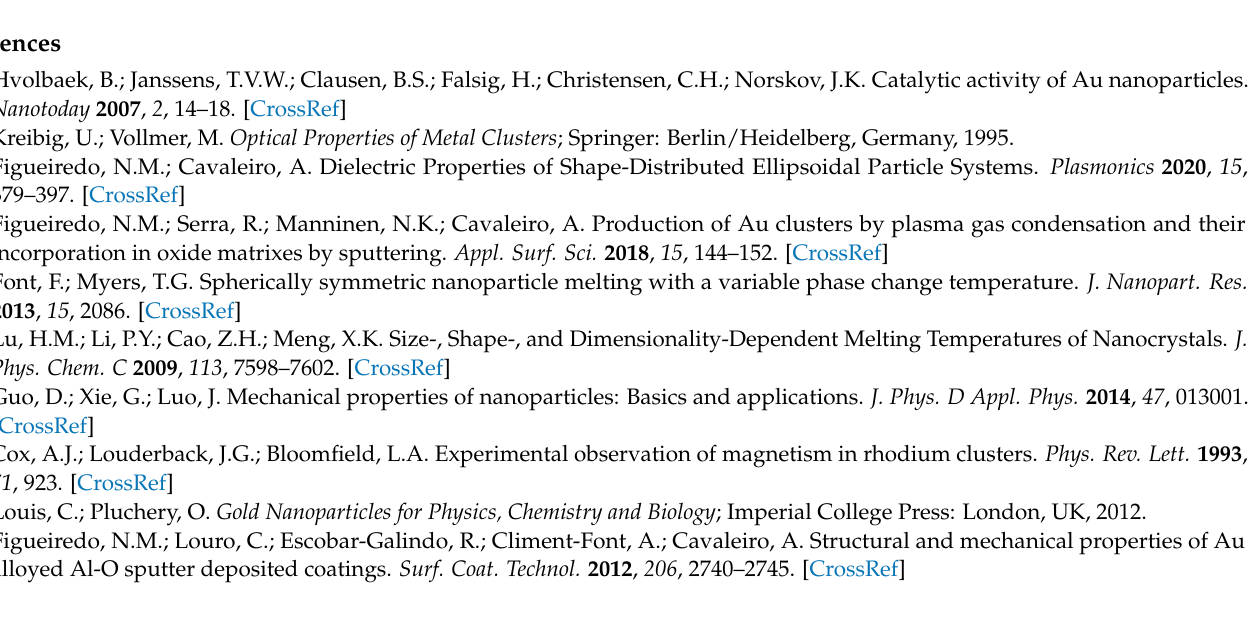
equivalent diameters for different samples, Figure S3: Color pictures of the scratch-tested 8 nm